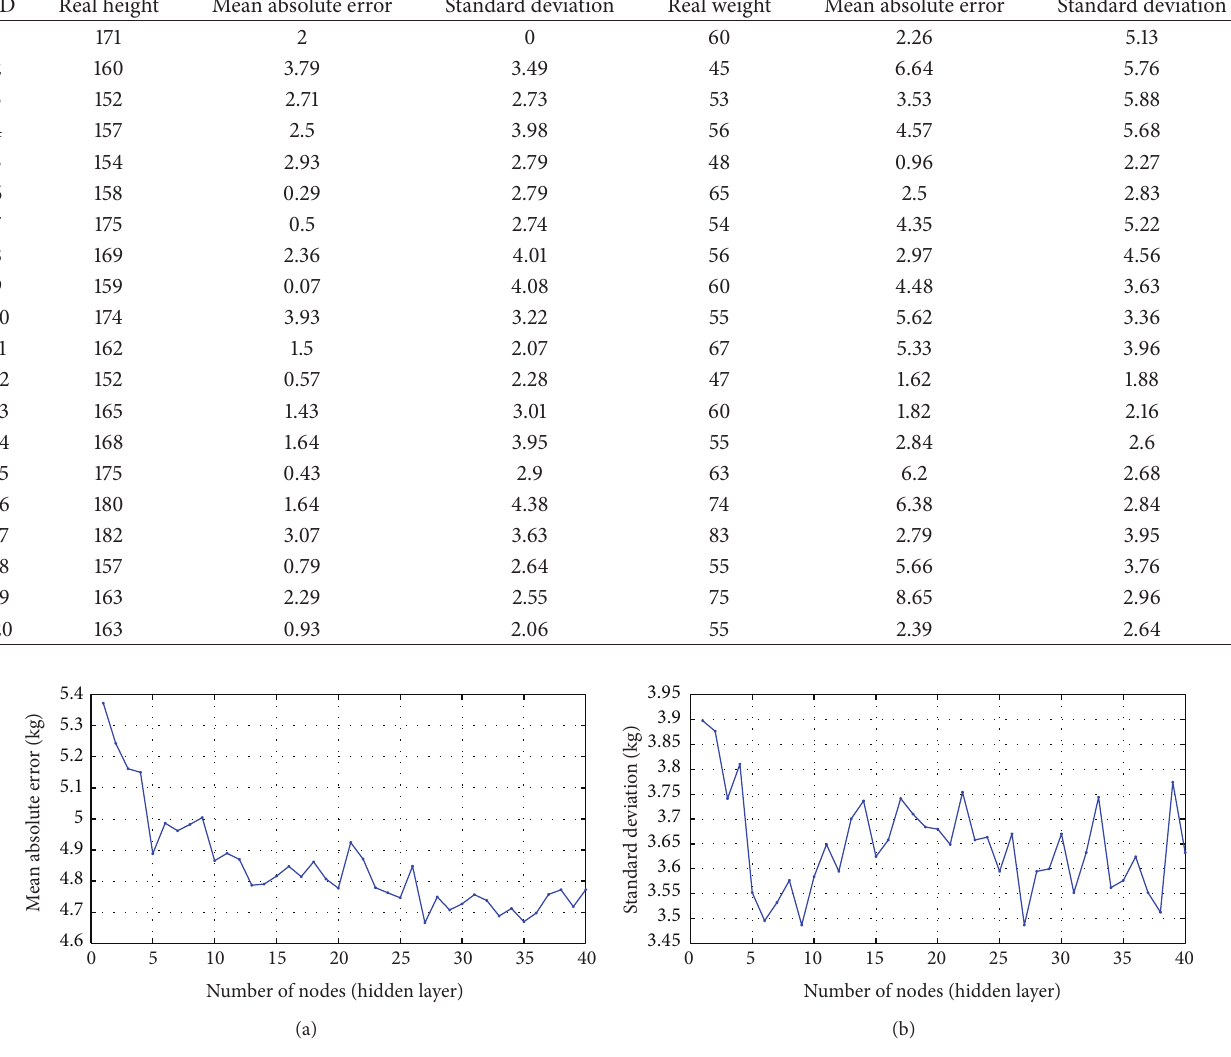
Figure 11: Performance of different nodes. (a) Mean absolute error and (b) standard deviation.